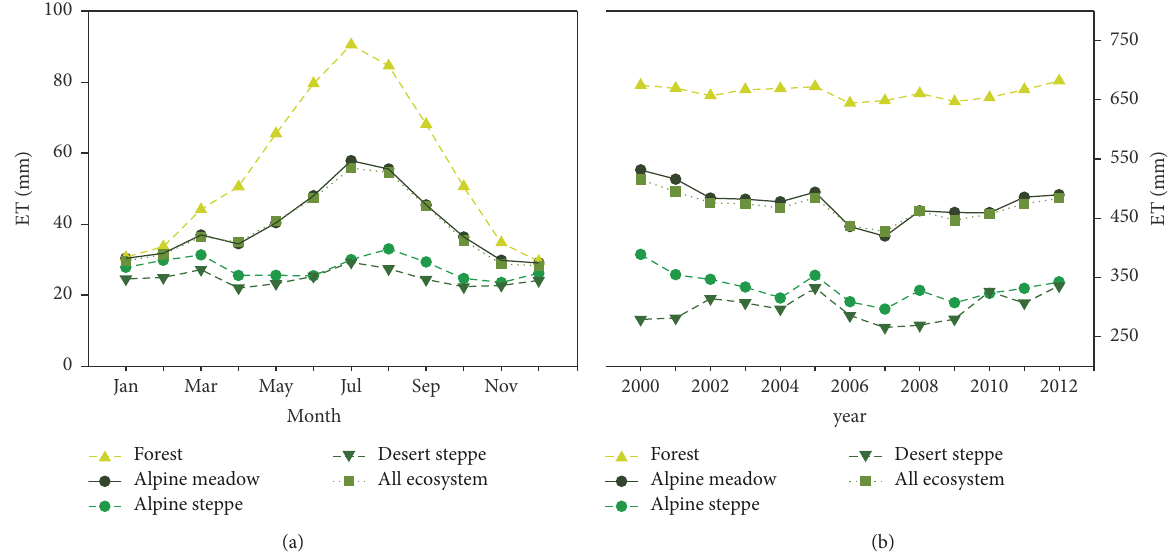
Figure 2: Temporal patterns of ET across the Tibetan Plateau. Graphs (a) and (b) represent variation ET of months January–December and years 2000–2012, respectively.